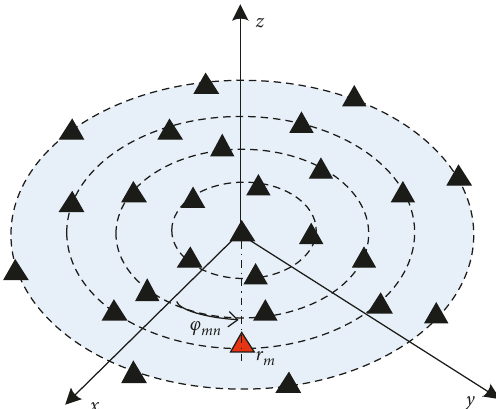
Figure 1: Geometry of CRA, where r m is the radius of the m -th ring and φ mn is the azimuth angle of the n -th element on the m -th